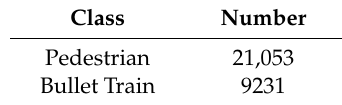
Table 7. The number of each class on the railway dataset.